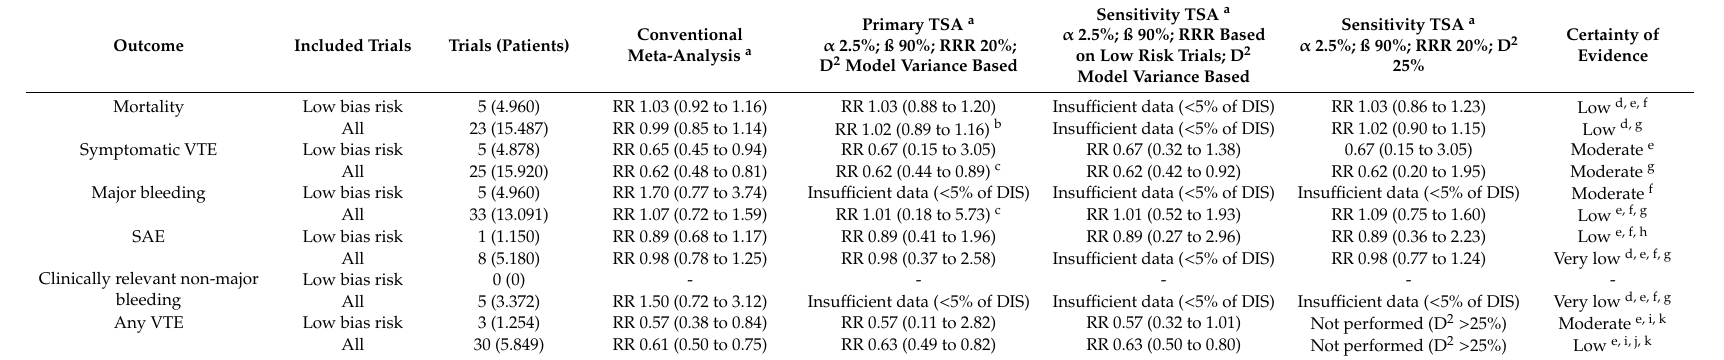
Table 2. Conventional meta-analysis and trial sequential analysis